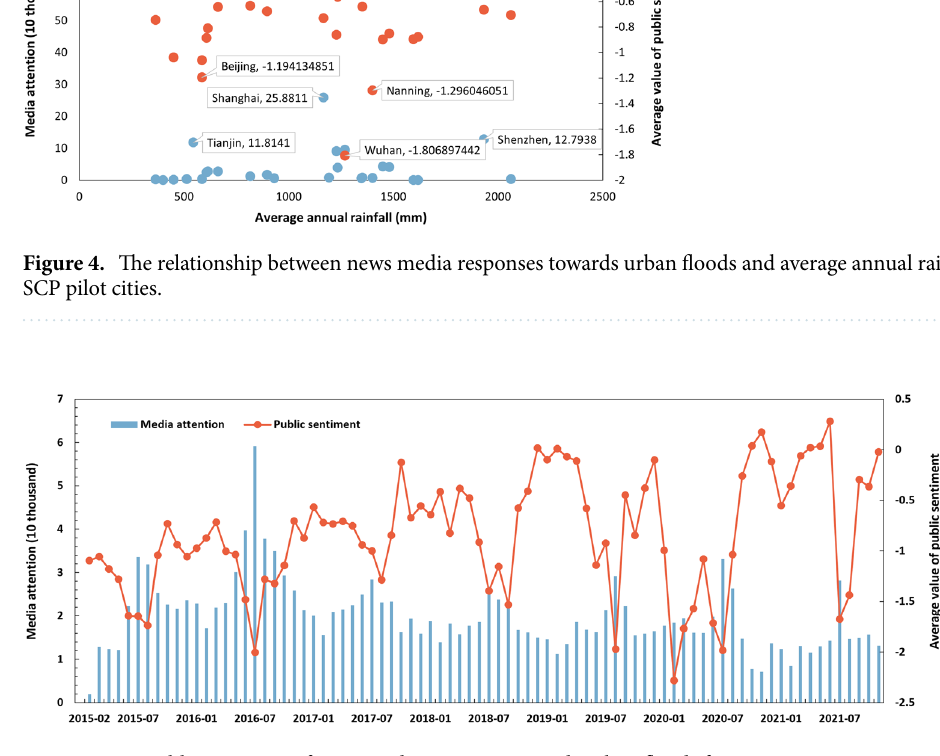
Figure 5. Monthly variations of news media response towards urban floods from 2015 to